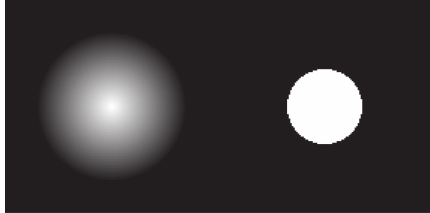
Figure 2: Images of a cone and a disk. The intensity in both images are between 0 and 1. See text for